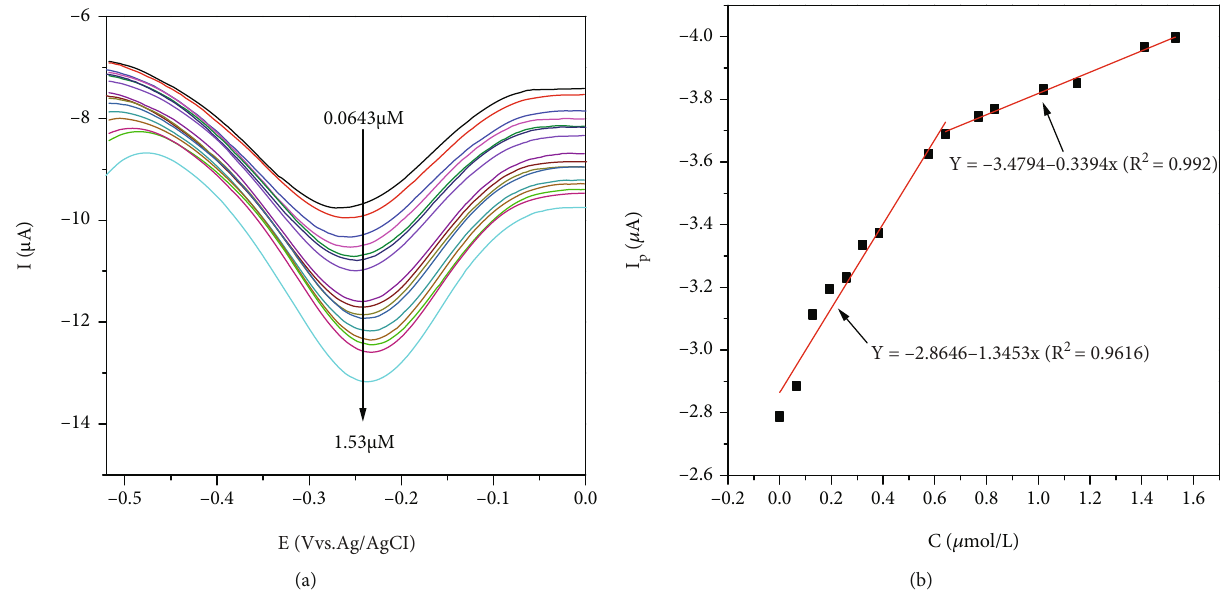
SO over MIL-53 (Fe)/GCE. (b) The linear dependence of I p with 2 4